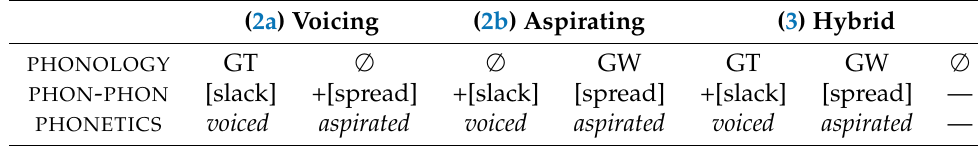
Table 6. Potential Western Armenian laryngeal representations and their